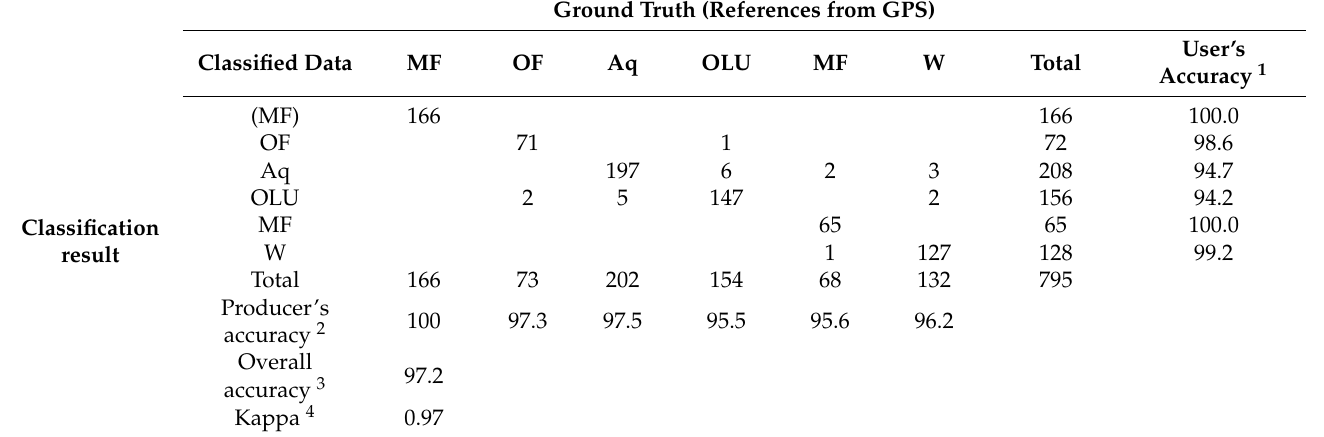
Table 3. Error matrix based on a random sample of 795 points, which were cross-classified using the LULC map classified in 2020 and ground-truthing, in which each row and column represents one category in the interpreted map. The left-hand side of the table has the categories on the standard map/data. The top of the table comprises the k categories representing the product of the created map to be evaluated. The values in the matrix indicate the numbers of pixels. Ground Truth (References from